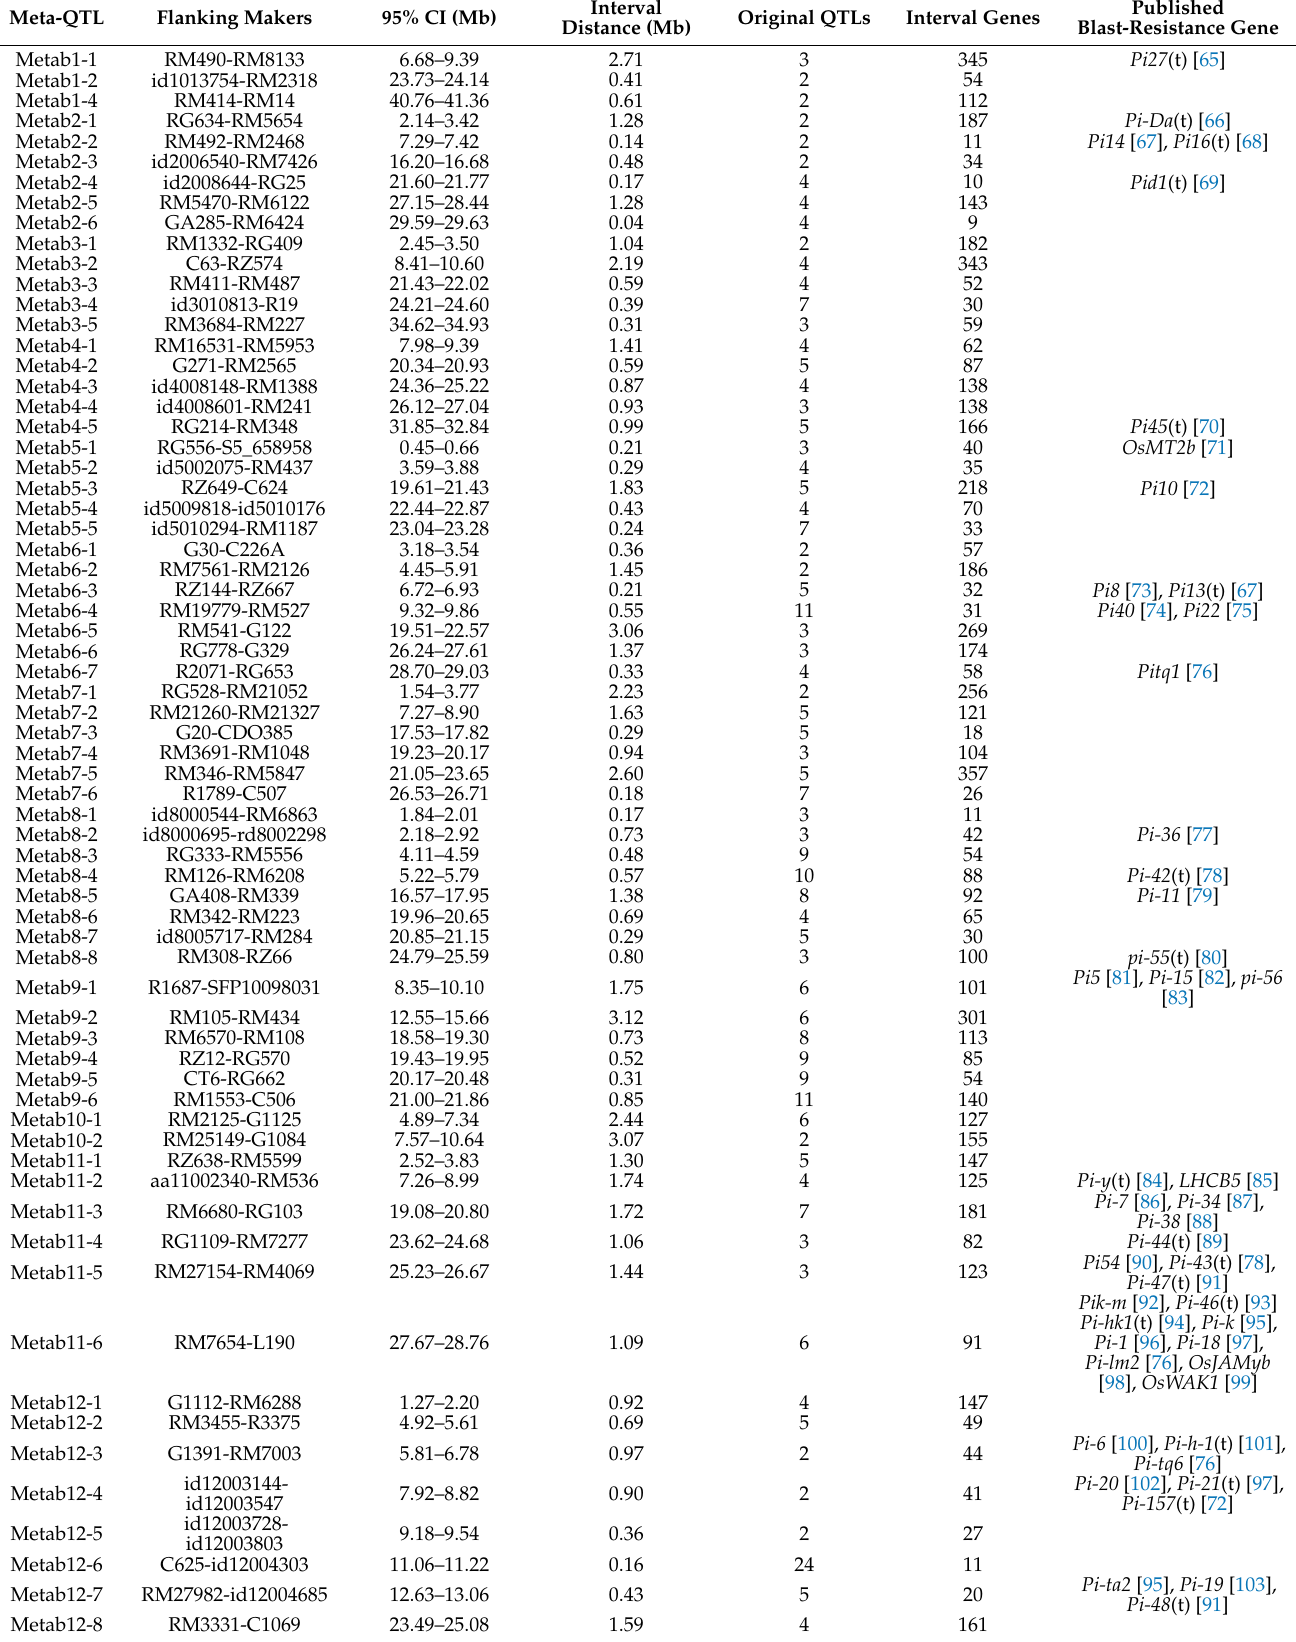
Table 1. 67 blast-resistant meta-QTLs in